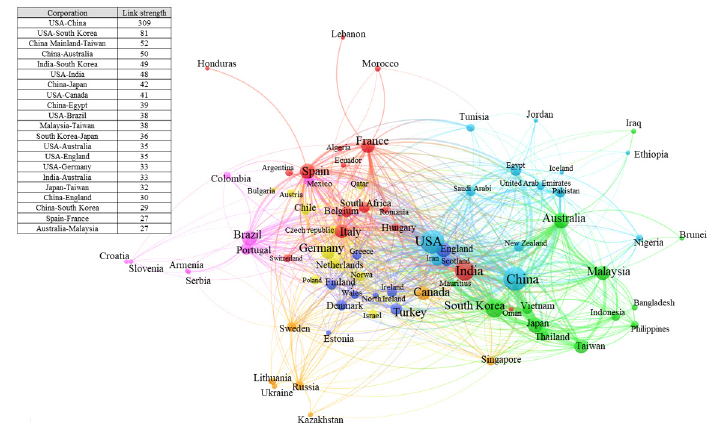
Figure 6. The social network of international cooperation across countries visualized by